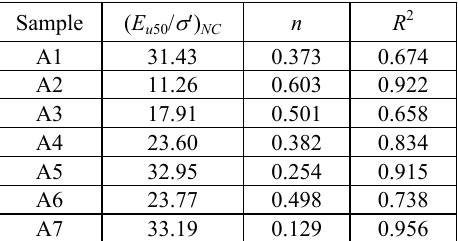
Table 4. Parameters of modified SHANSEP